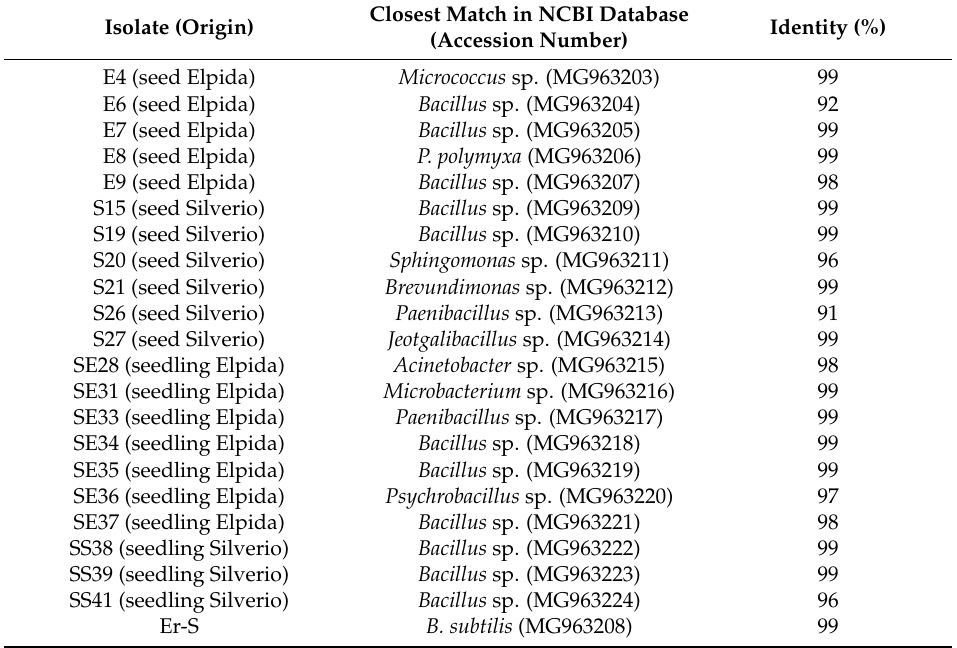
Table 3. Identification of endophytic bacteria from tomato seeds and seedling using sequences of the 16S rDNA gene.